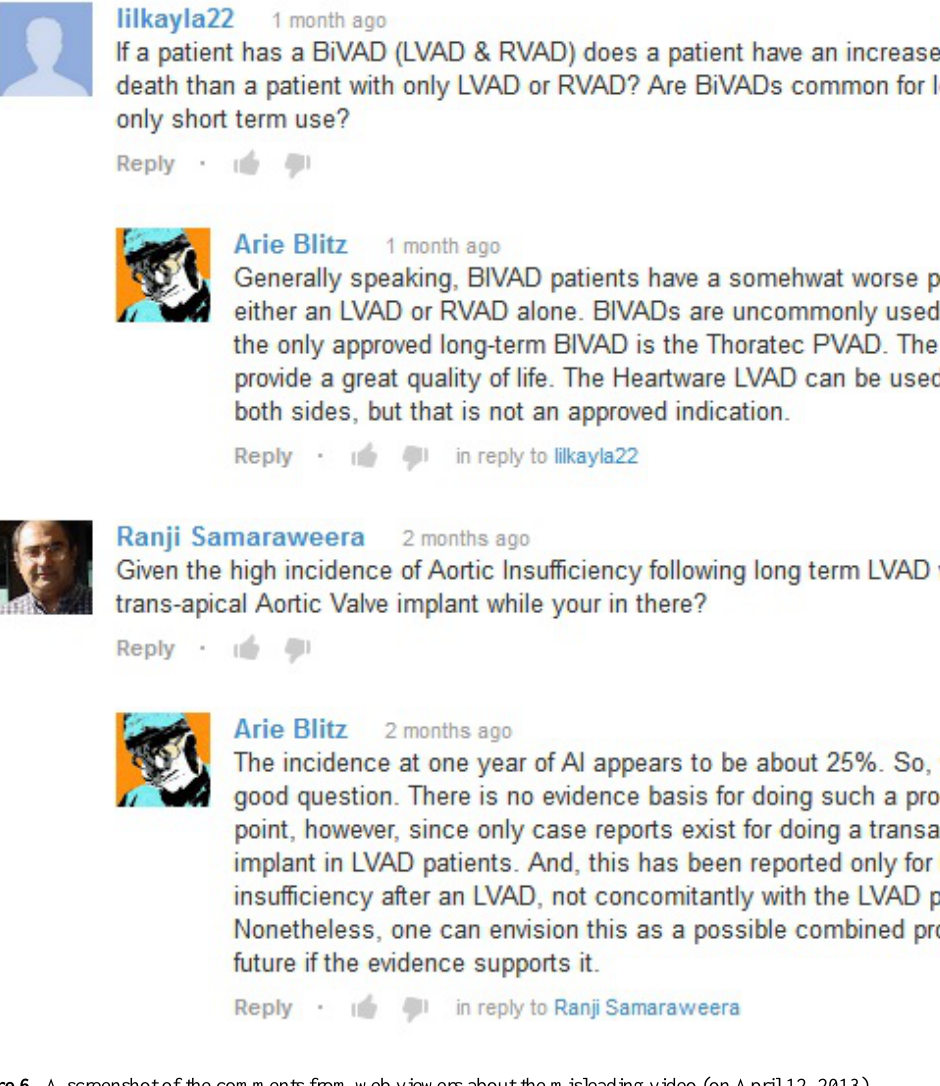
Figure 6. A screenshot of the comments from web viewers about the misleading video (on April 12,